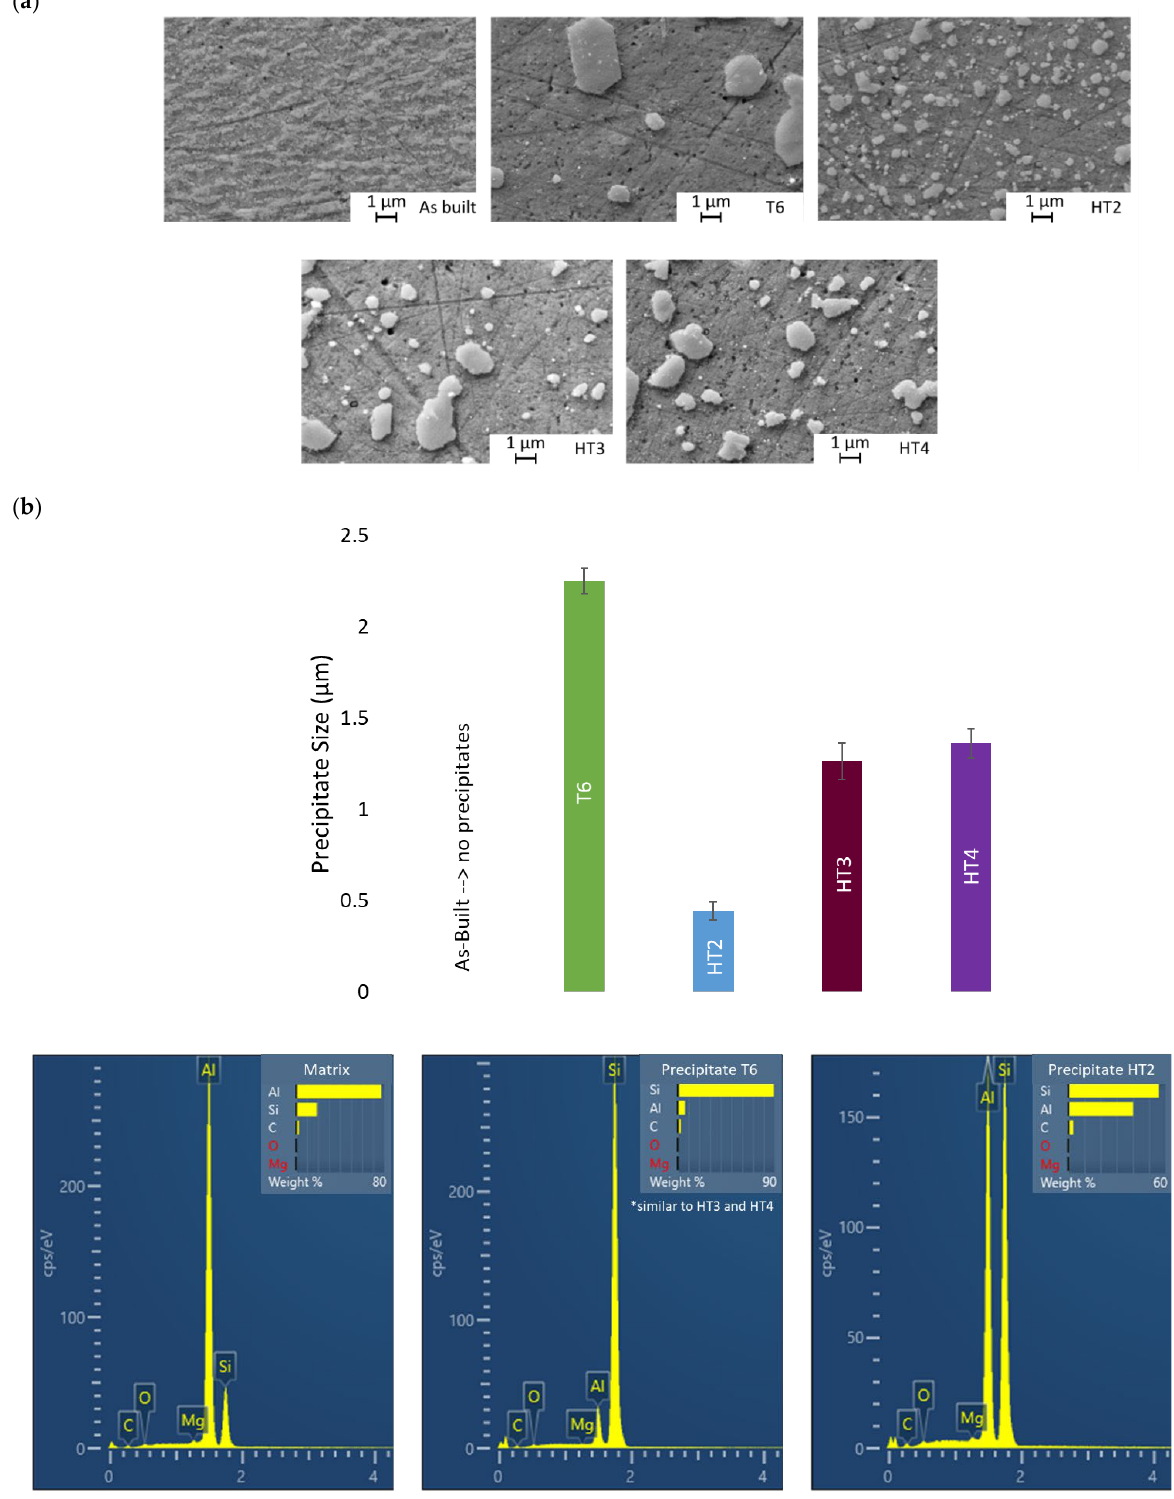
Figure 4. ( a ) SEM images of as-built, T6, HT2, HT3 and HT4 specimens for precipitation analysis. As-built shows no precipitates,T6 shows the largest precipitates, followed by HT4, HT3 and HT2; ( b ) mean precipitation size and standard deviation for all sample conditions; ( c ) EDX analysis of matrix and precipitate compositions.